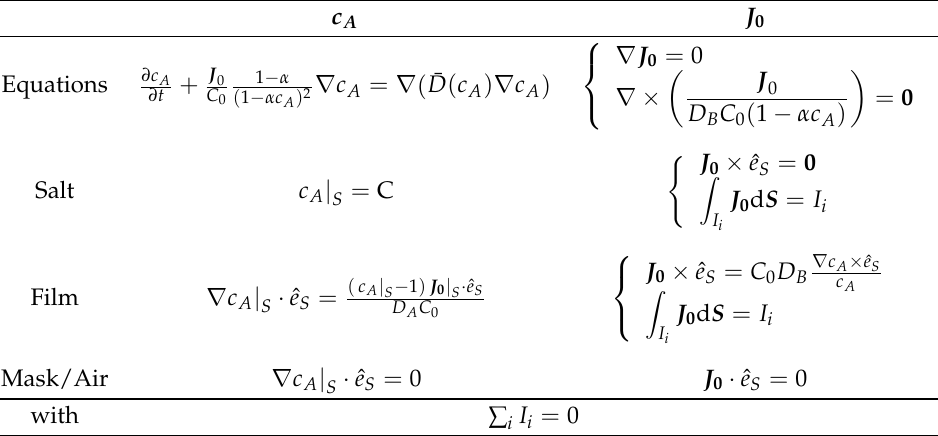
Table 1. Complete formulation of the IE problem (equations and boundary conditions), for the most common IE processes, in terms of the normalized concentration of dopant cations c A and the total flux density J 0 ; ˆ e S is a unit vector perpendicular to the sample surface, and C is a constant, which mainly depends on the dopant concentration in the salt.